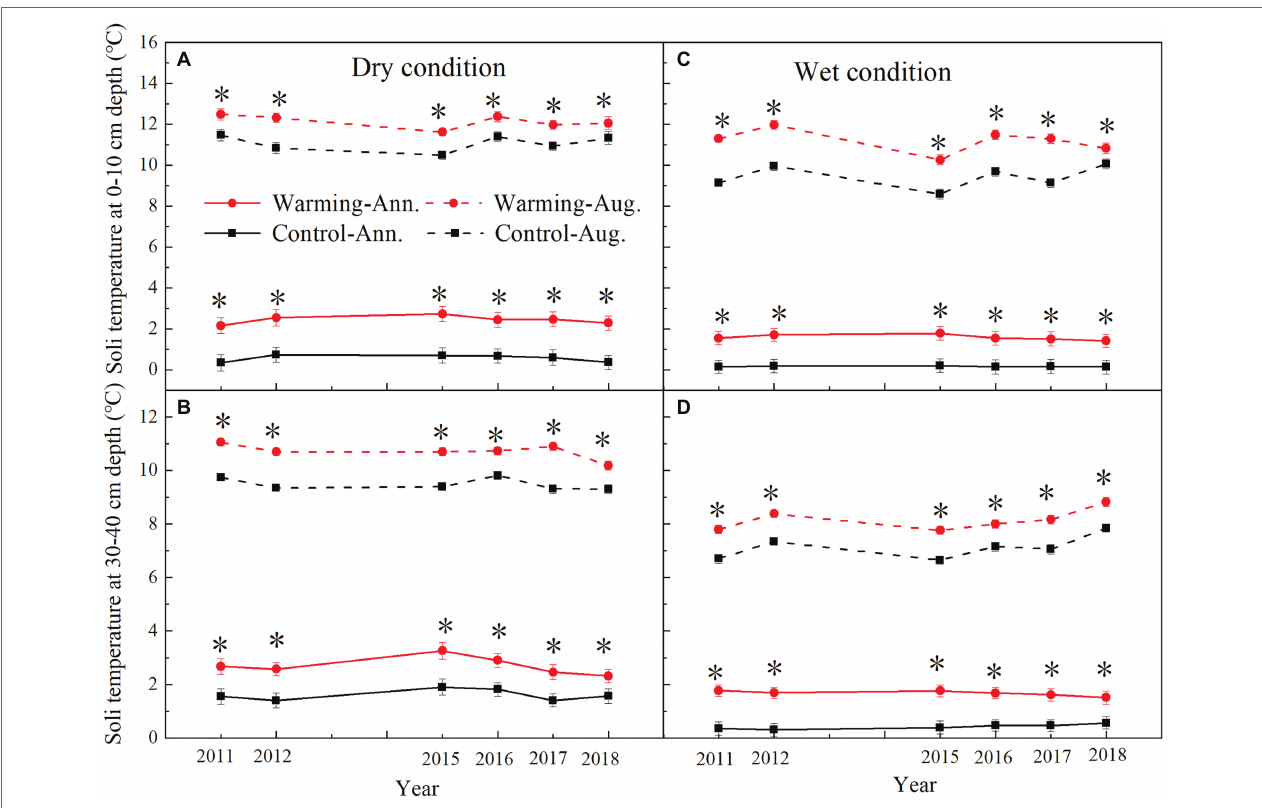
TABLE 1 | Results ( F values) of repeated-measures ANOVA of the effect of soil moisture condition (P), warming treatment (W), year, and their interactions on community aboveground biomass (AGB), AGB of grasses (Grasses), AGB of sedges (Sedges), and AGB of forbs (Forbs), and species richness (SR); the effect of soil moisture condition (P), warming treatment (W), year, depth, and their interactions on soil temperature (ST) and soil moisture (SM). Variance source